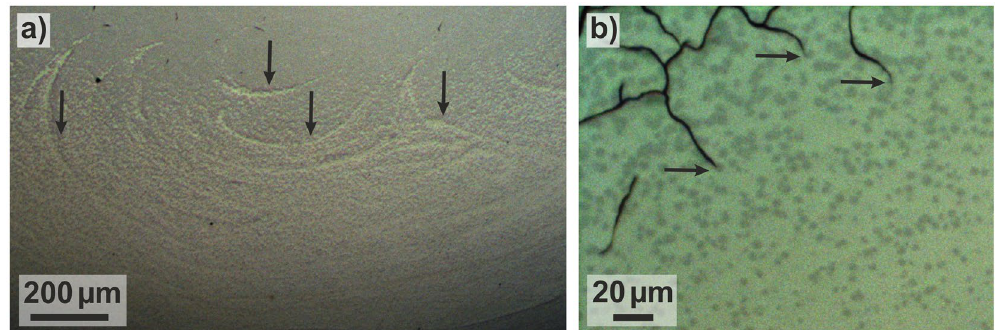
Figure 6. Partially crystalline microstructure of a Zr 52.5 Cu 17.9 Ni 14.6 Al 10 Ti 5 BMG flash-annealed at ϕ ave = 37 K/s to T ej = 878 K. ( a ) Optical micrograph (OM) of a BMG heated. The crystals are preferentially aligned along the eddy currents (brighter curved traces marked with vertical arrows). ( b ) OM of the same BMG specimen depicts cracks, which form and propagate in the crystalline phase network and terminate in the amorphous